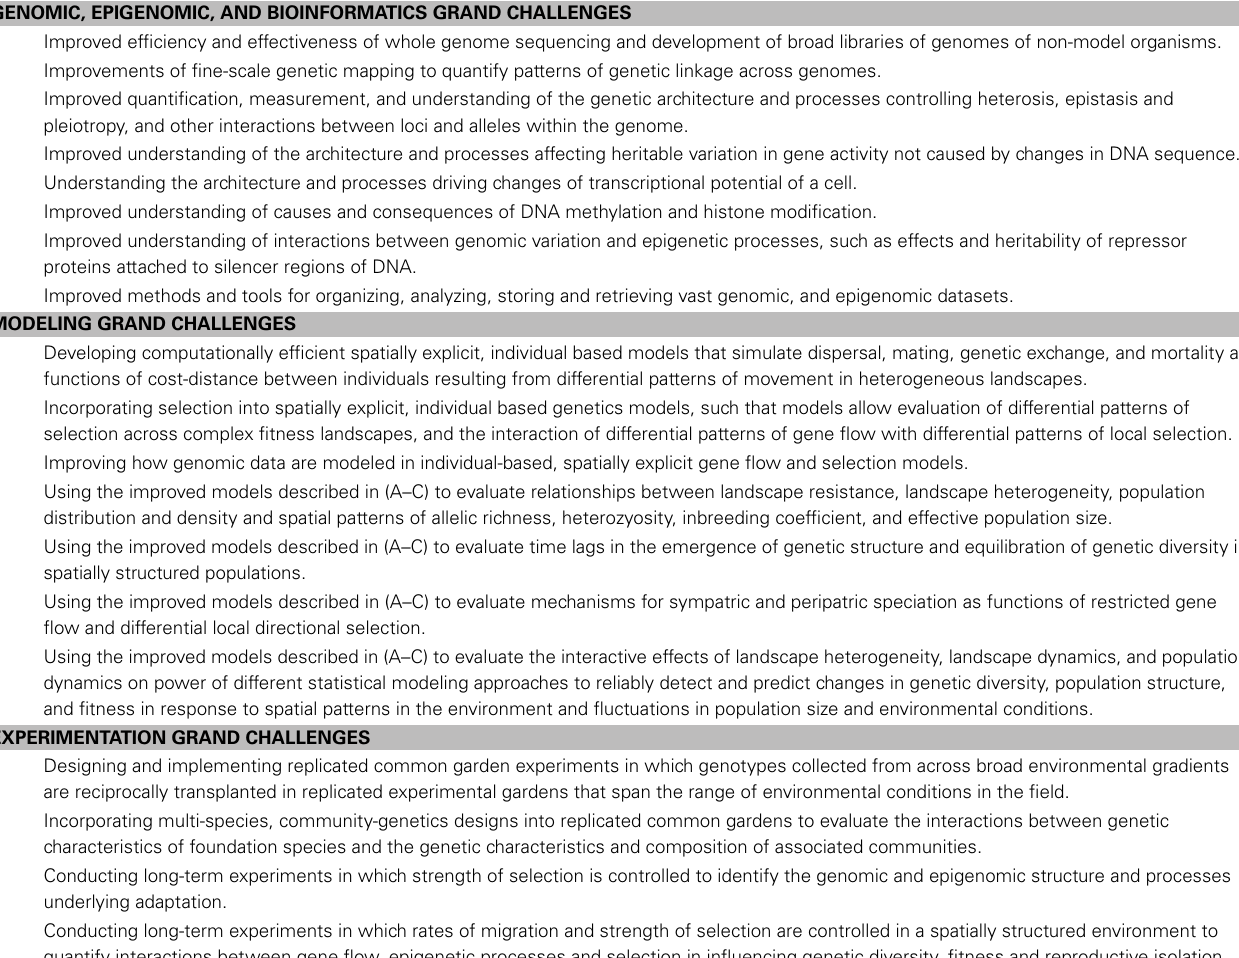
Table 1 | Grand challenges facing evolutionary and population genetics related to genomics, epigenomics, bioinformatics, modeling and experimentation, and their